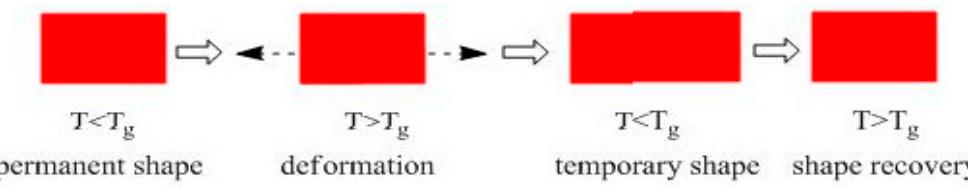
Figure 2. Physical process of shape recovery for a thermo-sensible material with memory shape